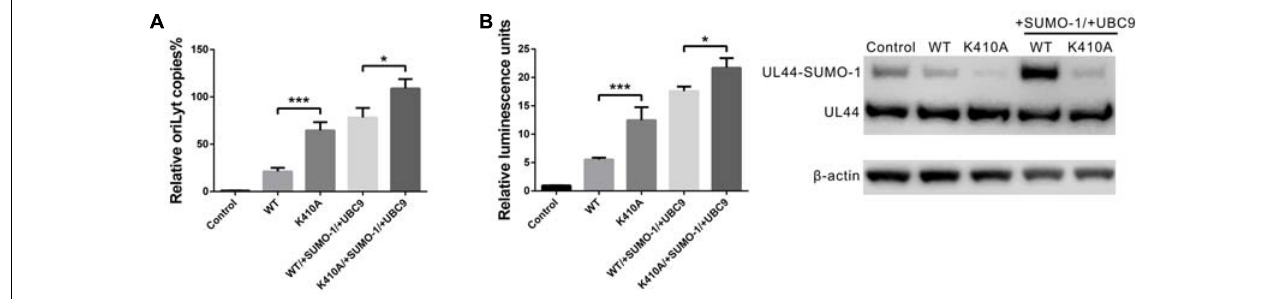
FIGURE 6 | Mutation of UL44 410 lysine enhanced oriLyt-dependent DNA synthesis in transfection-replication assays. (A) HFF cells were transiently cotransfected with pCMV-HA-UL44 (wild-type or K410A mutant) and all other plasmids as indicated in Table 2 , or without UL54 expression plasmid as control. SUMO-1 and UBC9 expression plasmids were also cotransfected in certain groups as indicated. Total cellular DNA was harvested 5 days post-transfection and was cleaved with Dpn I, and then was used as qPCR template to determine the copies of oriLyt-containing plasmid pGL3-14. Each sample was done in triplicate. Each set of assays was repeated 3 times and a representative one was shown. (B) Vero cells were transiently cotransfected with HA-UL44 (wild-type or K410A mutant) and all other plasmids as indicated in Table 2 , or without UL54 expression plasmid as control. SUMO-1 and UBC9 expression plasmids were also cotransfected in certain groups as indicated. Luciferase activity was measured 5 days after transfection. Firefly luciferase activity was normalized to Renilla luciferase activity for each sample. To confirm the conjugation of UL44 with SUMO-1, partial of cell lysates were directly probed with anti-HA antibody to visualize UL44. Analyses were repeated 3 times and the results were the average of triplicate experiments. Error bars = SD. * denotes p < 0.05, and *** denotes p < 0.001 by two-tailed unpaired Student’s t -test between indicated two